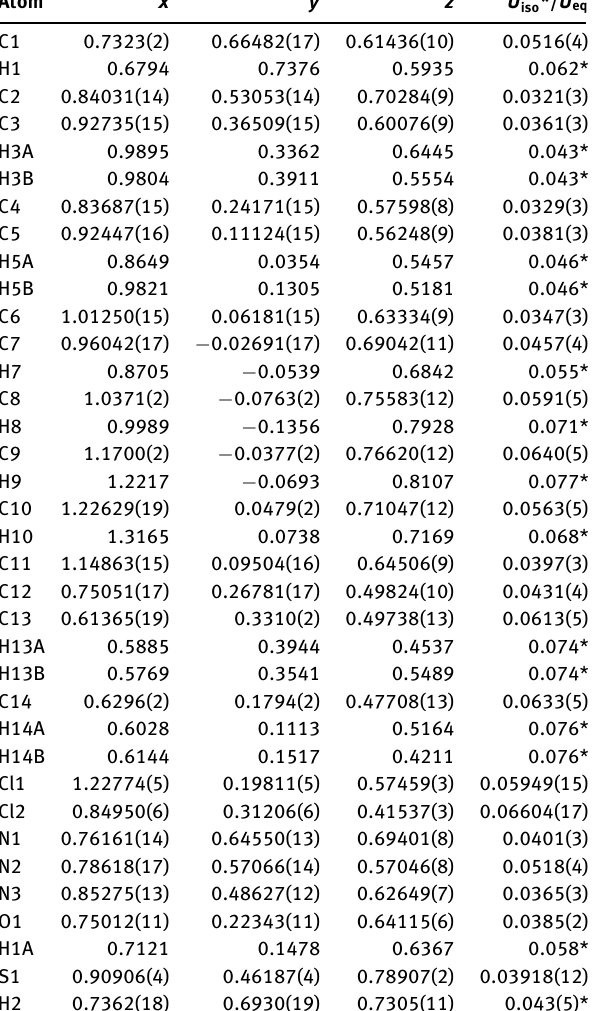
Table 2: Fractional atomic coordinates and isotropic or equivalent isotropic displacement parameters (Å 2